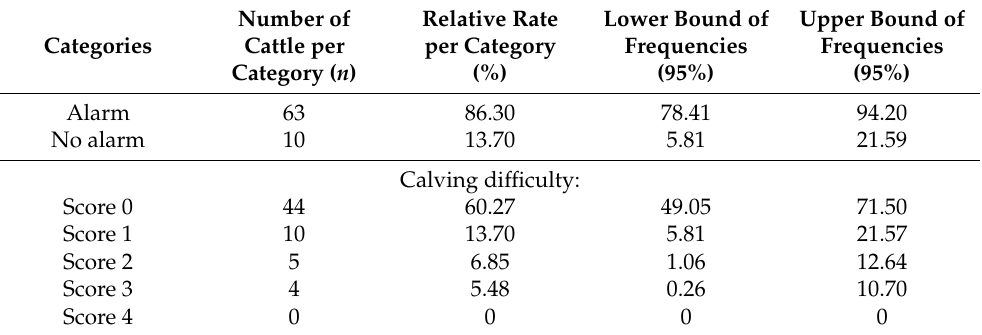
Table 3. Sensitivity of sensor and frequency of calving difficulty. 0—eutocia; 1—prolonged expulsive phase with normal fetal presentation; 2—slight dystocia with fetal abnormal presentation, resolution by manual correction; 3—moderate dystocia, foeto-maternal disproportion; 4—severe dystocia such as uterine torsion and cervical